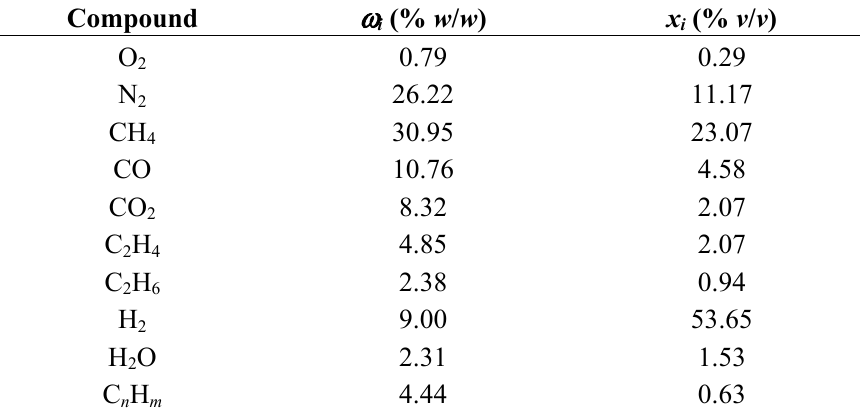
Table 6. Average chemical composition of coke oven gas (COG) expressed as weight and volume percentage.